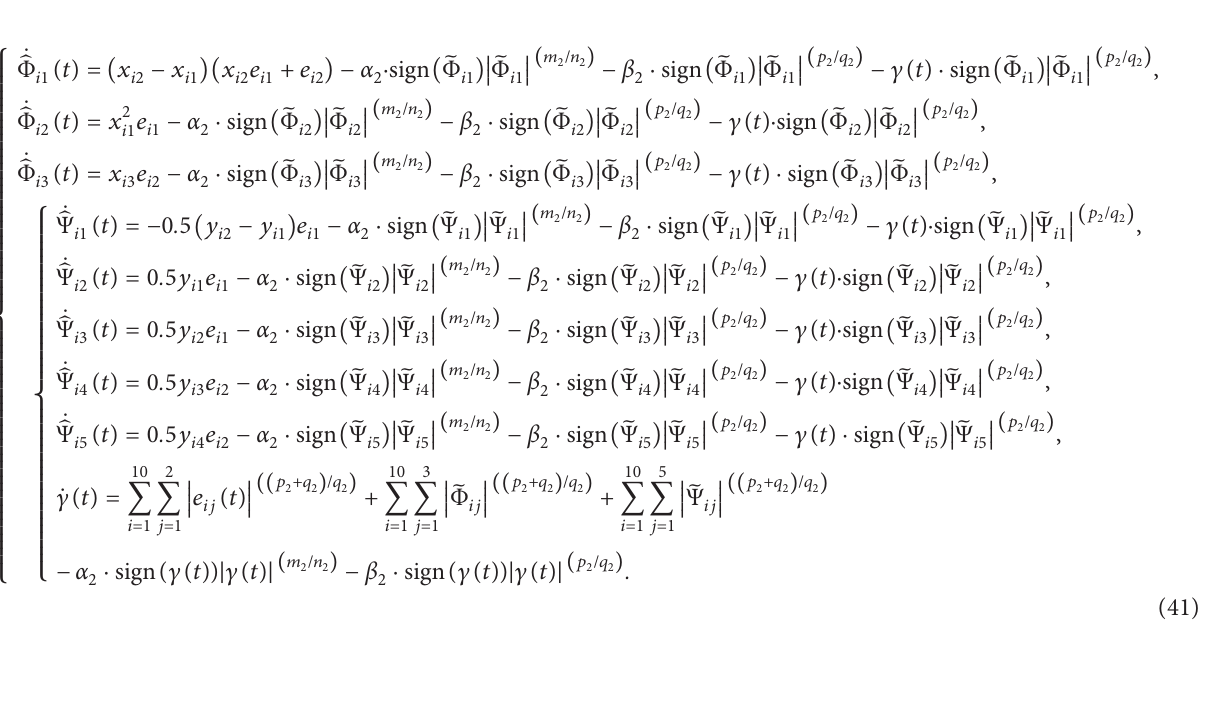
Figure 2: The synchronization errors between systems (35) and (36) by controller (27) in [53]. (a) e ( t )( i � 1 , 2 , ... , 10 ) (b) e i 2